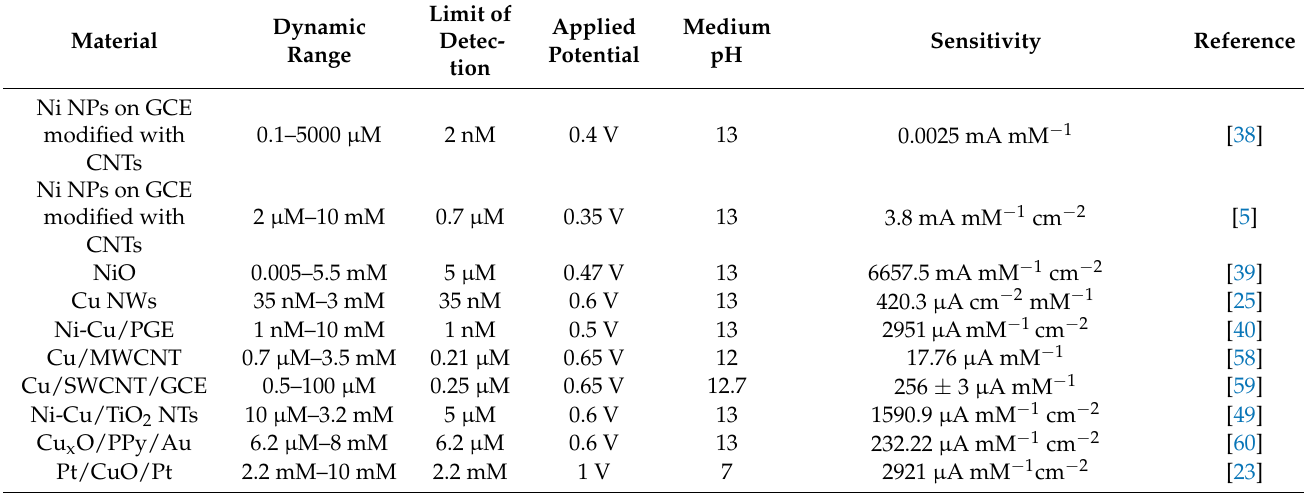
Table 1. A comparison between this work and the literature regarding non-enzymatic glucose detection.